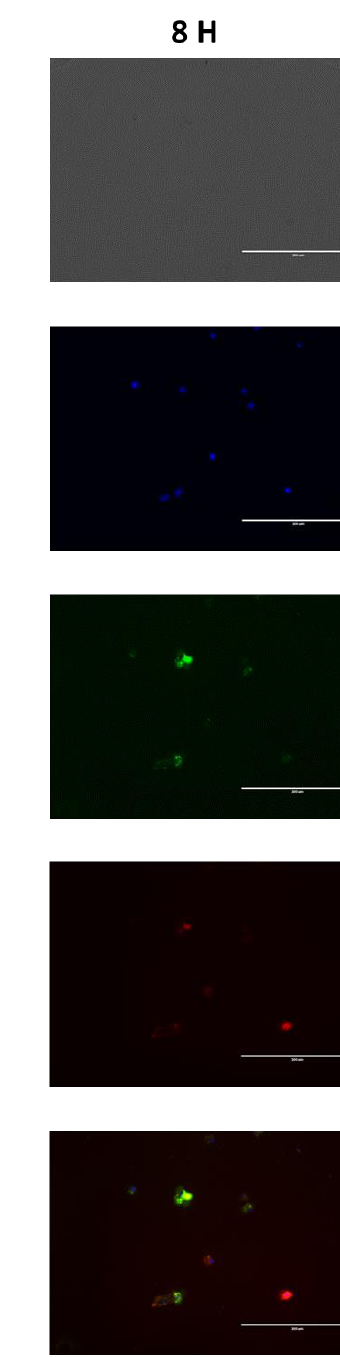
Figure 3. Alveolar macrophage phagocytosis of FITC chitosan nanoparticles at 0 and 8 h showing the nanoparticles inside of cell lysosomes at 8 h. The DAPI filter shows the nuclei, the FITC filter demonstrates the nanoparticles, and the RFP filter indicates the lysosomes.